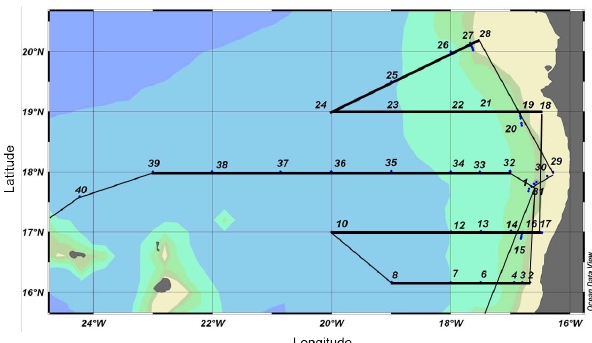
Fig. 1. Cruise track and locations of the sampling stations dur- ing the ATA-03 cruise in February 2008. Bold black lines indicate the onshore-offshore transects. The colour coding represents the bathymetry of the sampling area. Dark blue to light brown indicate deep waters (3600m) to shallow waters